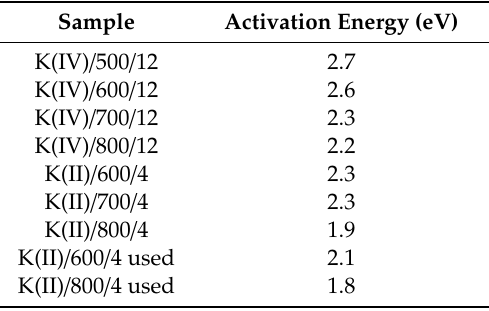
Table 8. Activation energies of K desorption for selected